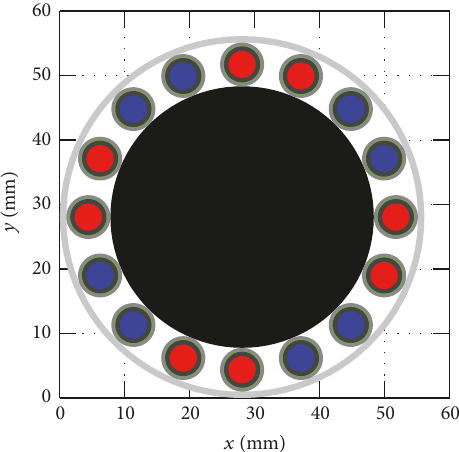
Figure 13: Tether cross section visualization with electrical cables placed in the pattern (+ − )( − +)(+ − ) ... , with color coding as in Figure 8, with the parameters in Table 1 and Appendix A and with 𝑛 = 16 electrical c